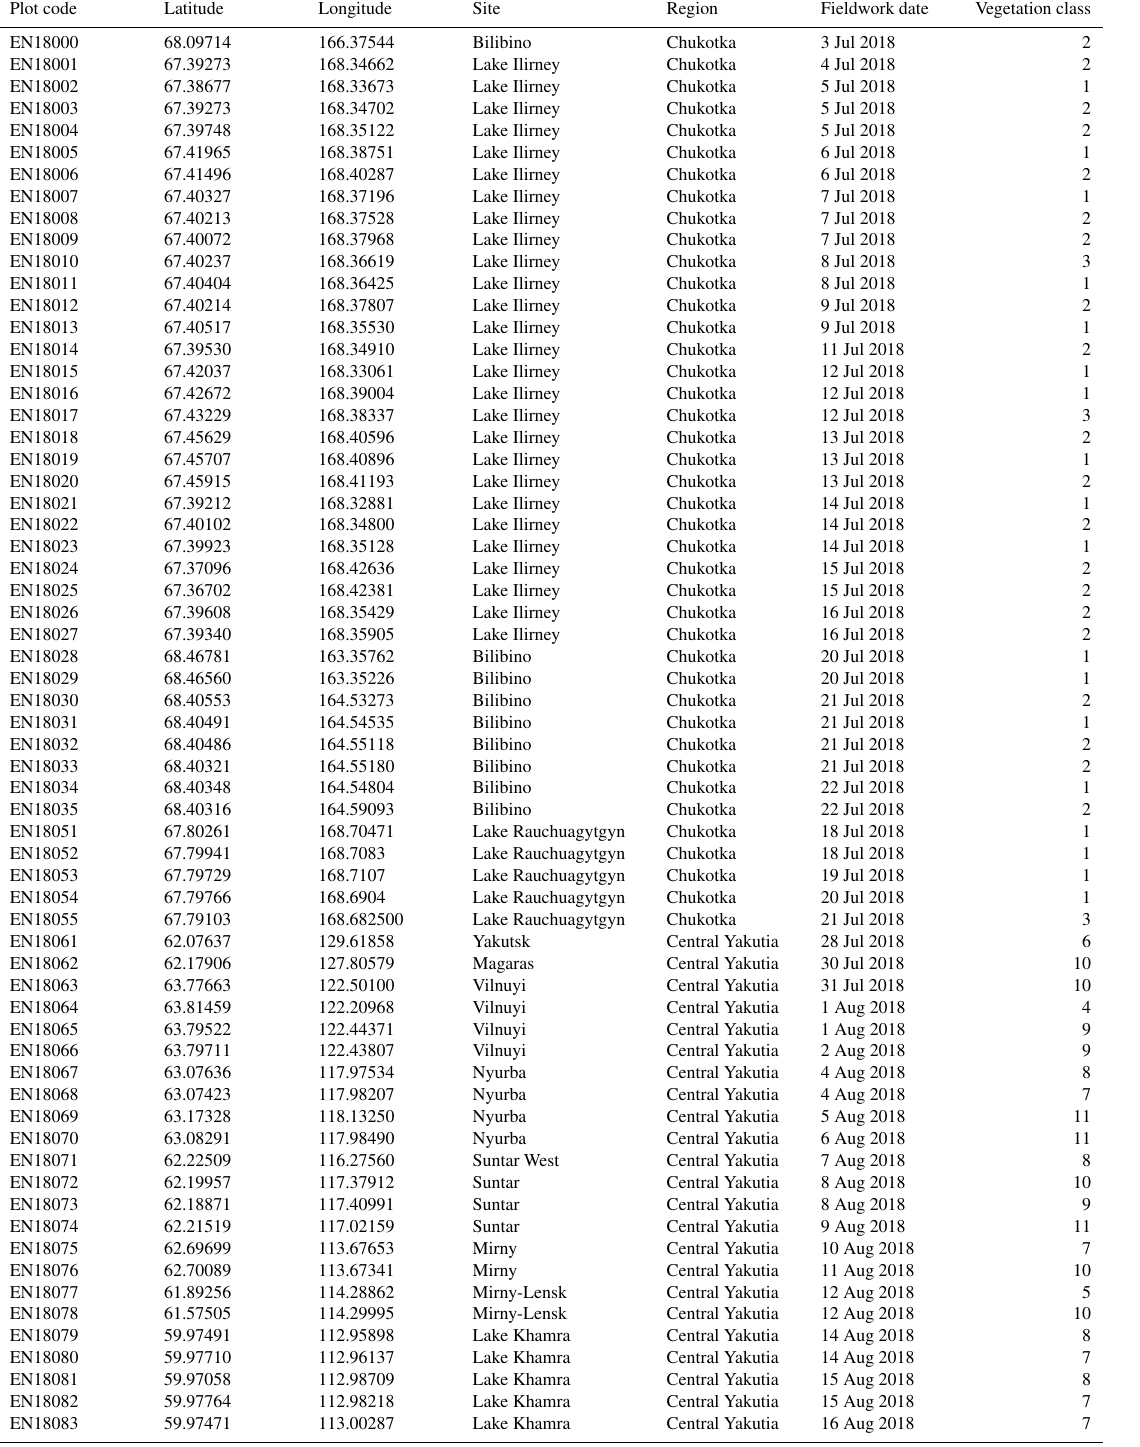
Table A1. An overview of the plots, the latitude and longitude of the central coordinates, the site name, the region (Chukotka or Yakutia), the visiting date of the vegetation plot in the field in 2018, and the vegetation class (used as labels for the 30m × 30m S2-patches, Table 2). Plot